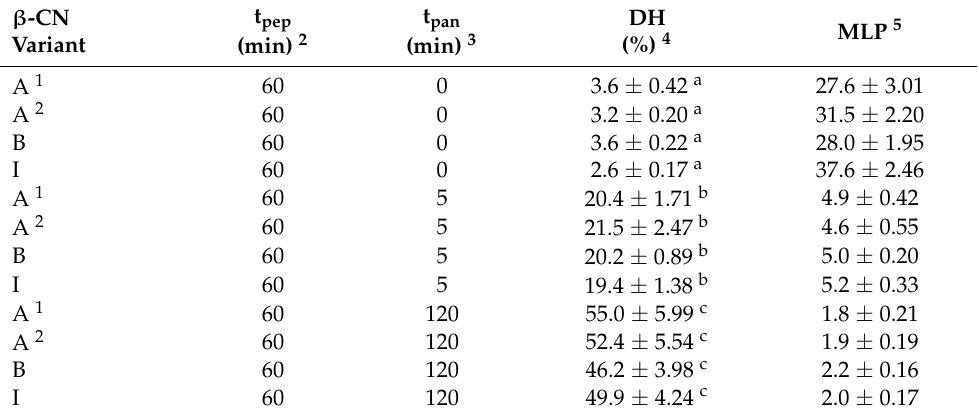
Table 3. In vitro gastrointestinal digestion of β -casein variants using pepsin and pancreatic enzymes 1 . β